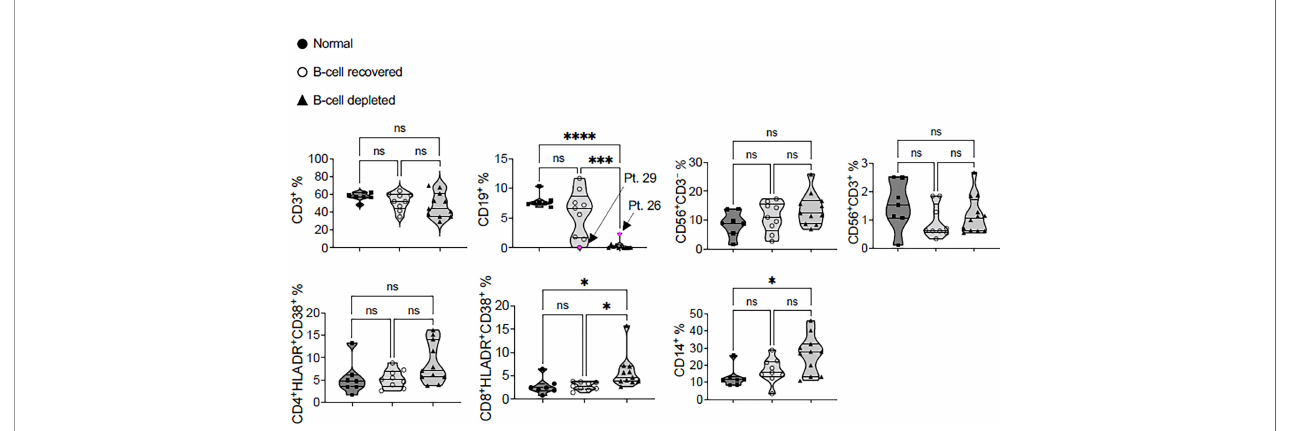
FIGURE 4 | Immunophenotyping of the post-SARS-CoV-2 vaccine PBMC samples of B-cell depleted, B-cell recovered AAV patients and healthy controls. Patient #29 is a B-cell recovered patient who was retreated with rituximab after completing the COVID vaccine and patient #26 recovered B-cells following the vaccination. All statistics were done using one-way ANOVA. *P < 0.05, ***P < 0.01, ****P < 0.001. NS, not signi fi